Question: What visual encoding does this figure use to show its data?
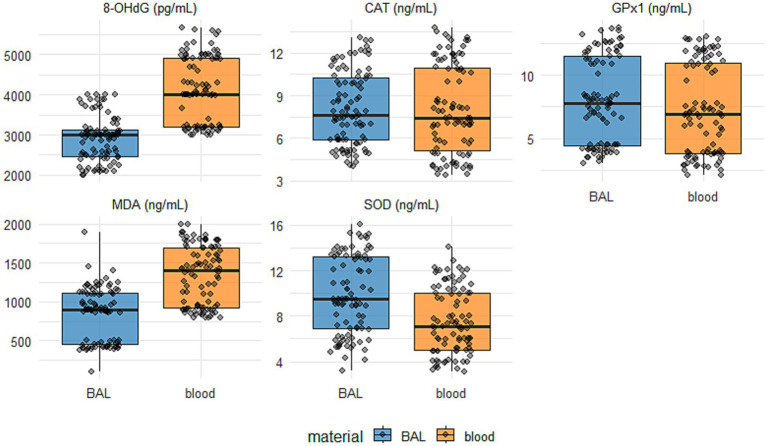
Answer: line